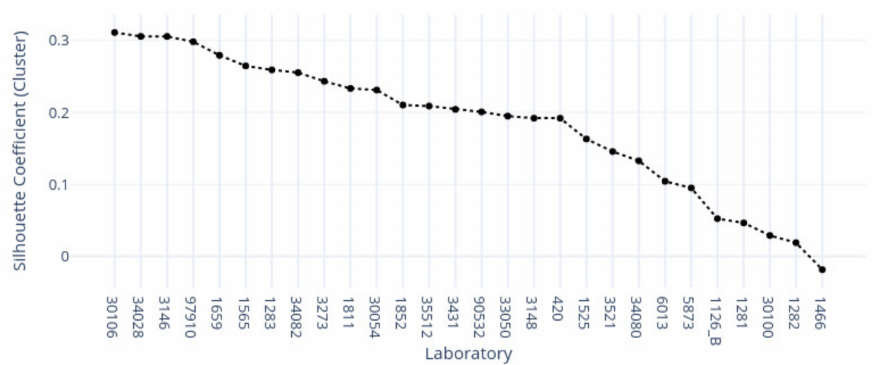
Figure 17. Silhouette scores for the first cluster found (C2) in colon samples across laboratories.